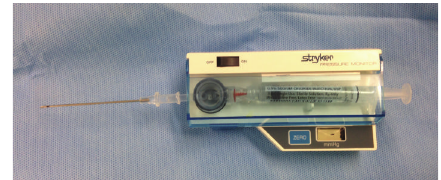
Figure 2: Stryker digital device.